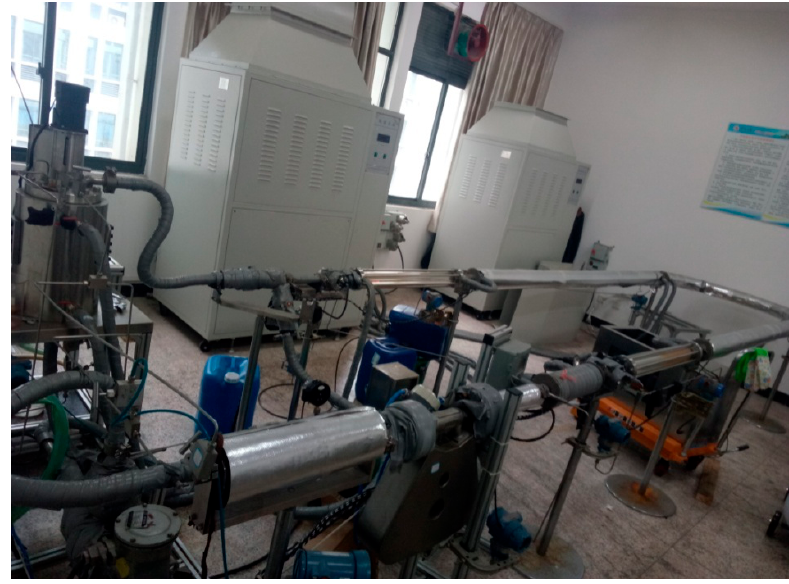
Figure 1. High-pressure flow loop at ChangZhou university.